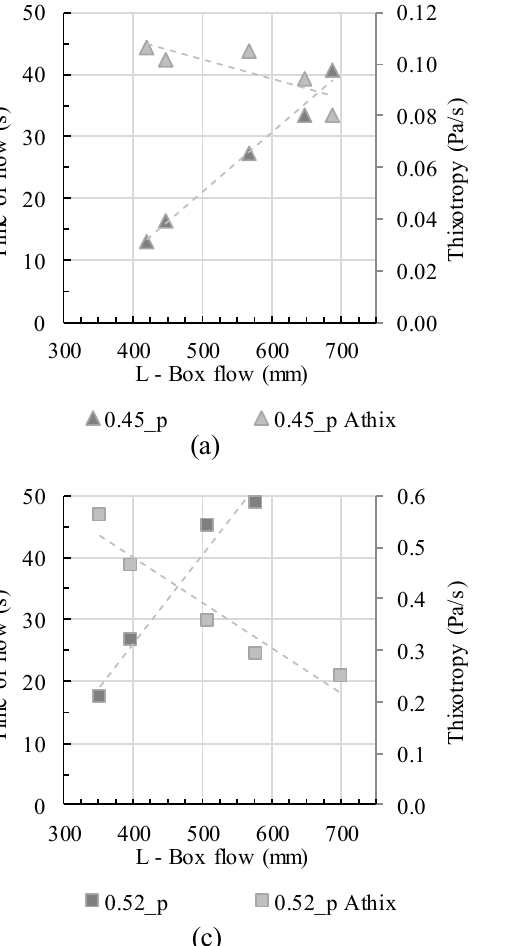
Figure 10. Correlation of L-box flow with flow time and thixotropy.